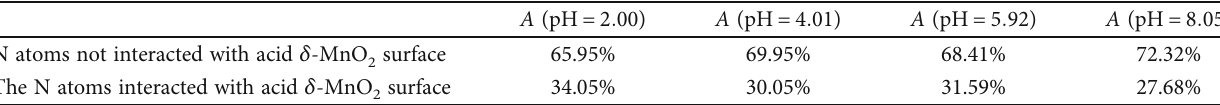
Table 3: The best fi t of N 1s XPS spectra for MB